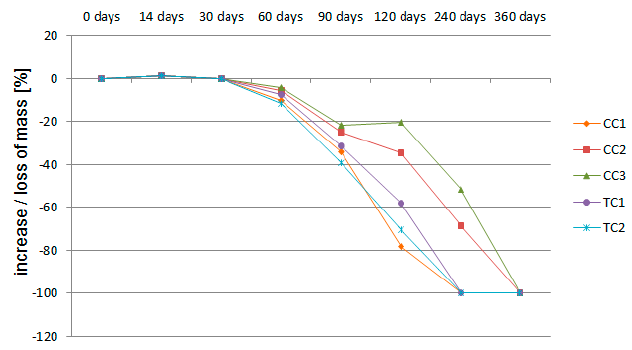
Figure 10. Changes in mass of samples.